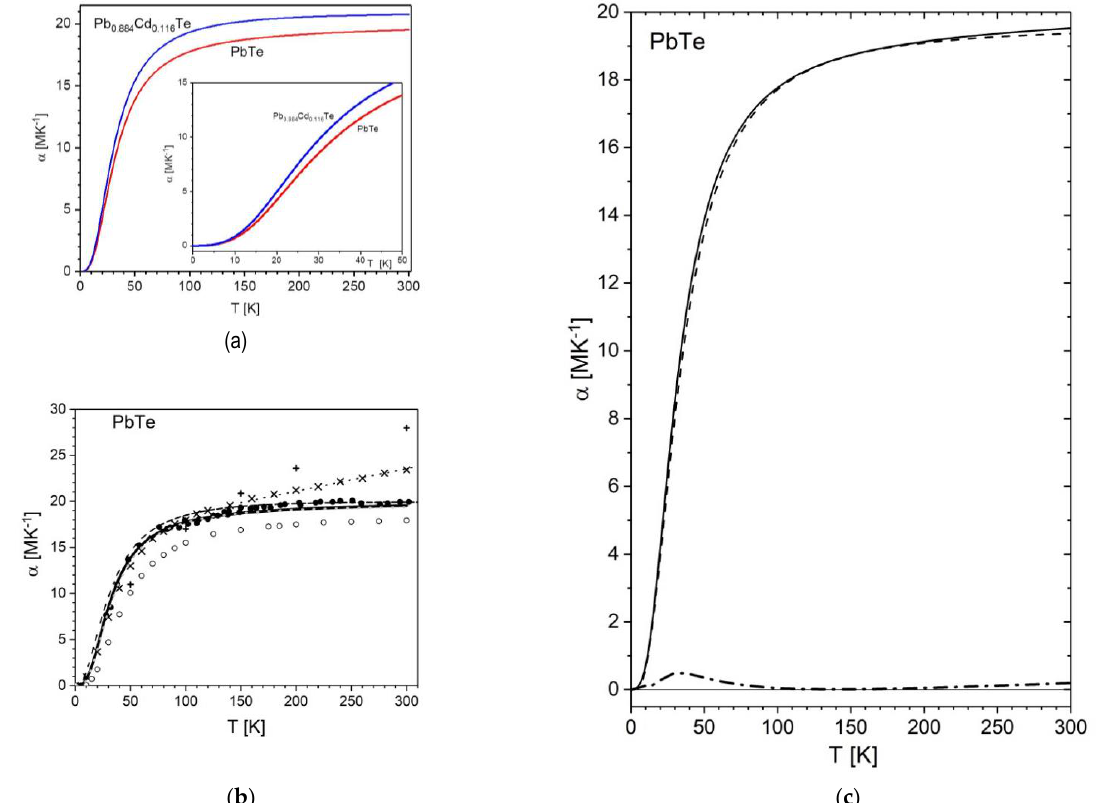
Figure 2. ( a ) Experimental variation of normalized unit-cell volume with temperature for PbTe (  ) and Pb 0.884 Cd 0.116 Te (  ) (the main figure). The corresponding dependencies of the absolute values of lattice parameters are shown in the inset. The Figure 3. Variation of thermal expansion with temperature, α ( T ). ( a ) The linear thermal expansion coefficient α ( T ) for PbTe Figure 3. Variation of thermal expansion with temperature, α ( T ). ( a ) The linear thermal expansion coefficient α ( T ) for PbTe Figure 3. Variation of thermal expansion with temperature, α ( T ). ( a ) The linear thermal expansion coefficient α ( T ) for PbTe uncertainties are smaller than the symbol size. The fits of Equation (1) (second-order Gr ü neisen approximation) are shown and Pb 0.884 Cd 0.116 Te as a function of temperature, was obtained from the experimental-data fitting using a second order and Pb 0.884 Cd 0.116 Te as a function of temperature, was obtained from the experimental-data fitting using a second order and Pb 0.884 Cd 0.116 Te as a function of temperature, was obtained from the experimental-data fitting using a second order in the figure and in the inset using red (PbTe) and blue (Pb 0.884 Cd 0.116 Te) solid lines, respectively. ( b ) Present temperature Grüneisen approximation (Equation (1)). The inset includes the magnified low-temperature part (0 – 50 K) of the α ( T ) run. Grüneisen approximation (Equation (1)). The inset includes the magnified low-temperature part (0–50 K) of the α ( T ) run. Grüneisen approximation (Equation (1)). The inset includes the magnified low-temperature part (0 – 50 K) of the α ( T ) run. dependence of the PbTe lattice parameter, compared to selected literature data. Present experimental points (  ) and the ( b ) Comparison of the present data for PbTe (black solid line) with previously reported experimental and theoretical data ( b ) Comparison of the present data for PbTe (black solid line) with previously reported experimental and theoretical data ( b ) Comparison of the present data for PbTe (black solid line) with previously reported experimental and theoretical data second-order Grüneisen approximation (thick solid line); experimental data of ref. [38] (  ), ref. [31] (  ), ref. [29] (thin of PbTe. Selected data from literature (from ref. [51] ( ⚫ ), [29] (black dashed line) (experimental), (from ref. [45] (  ); [46] of PbTe. Selected data from literature (from ref. [51] ( • ), [29] (black dashed line) (experimental), (from ref. [45] (+); [46] of PbTe. Selected data from literature (from ref. [51] ( ⚫ ), [29] (black dashed line) (experimental), (from ref. [45] (  ); [46] dashed line), ref. [39] (  ), ref. [34] (  ). The inset provides a comparison with theoretical data of ref. [45] (  and dashed (  ), from ref. [8] (  ) (theoretical)) are shown. ( c ) Comparison of the present experimental data (solid line, also shown as (  ), from ref. [8] (  ) (theoretical)) are shown. ( c ) Comparison of the present experimental data (solid line, also shown as ( line), ref. [46] (  and dashed line), ref. [39] (  and dashed line), and ref. [50,108] (dot-dash line). (strongly overlapping) dotted line in ( b )), theory [60,108] (dashed line), difference curve (dash-dot line). (strongly overlapping) dotted line in ( b )), theory [60,108] (dashed line), difference curve (dash-dot